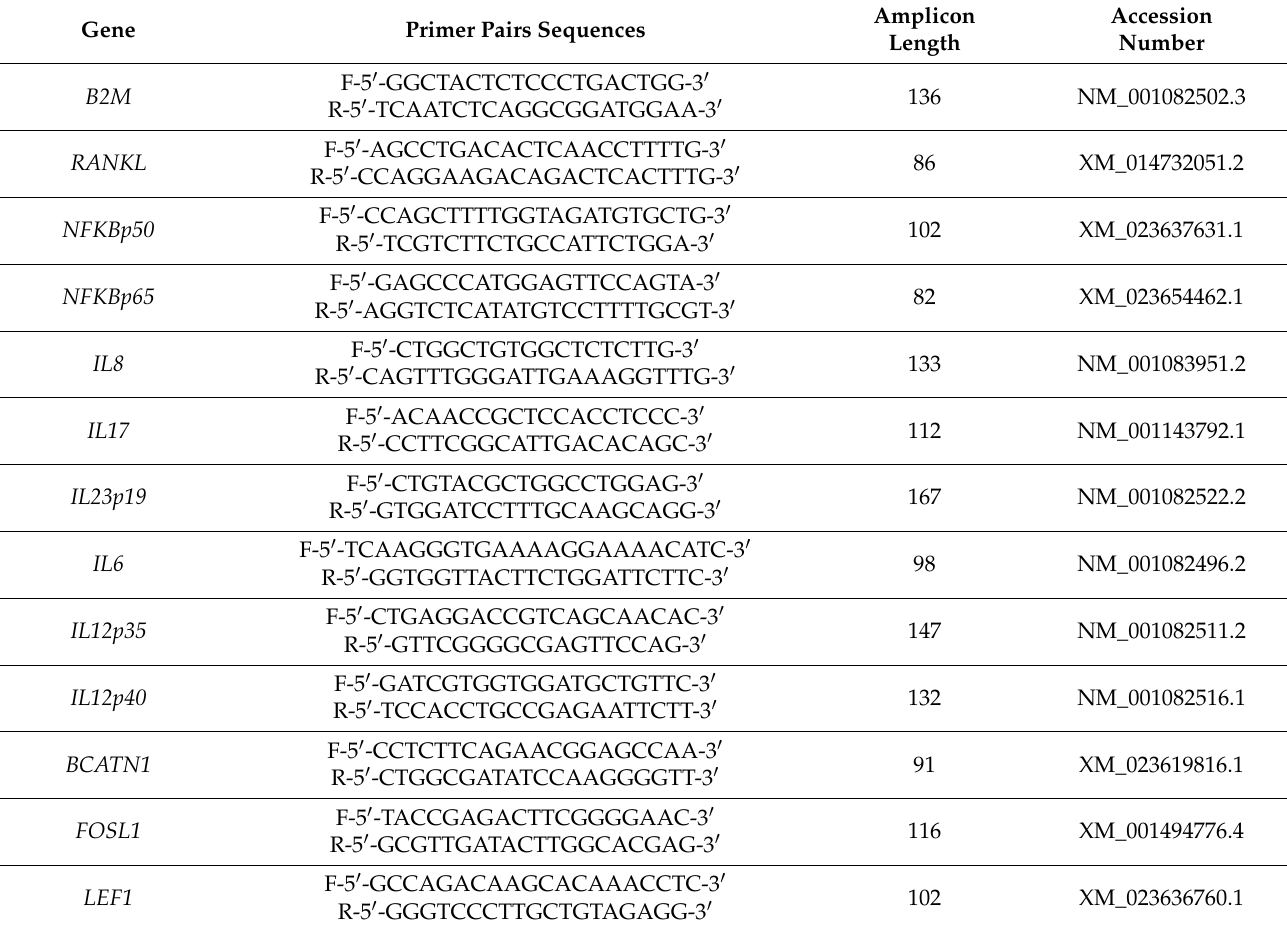
Table 2. Primer set for the host gene expression evaluation. Primer Pairs